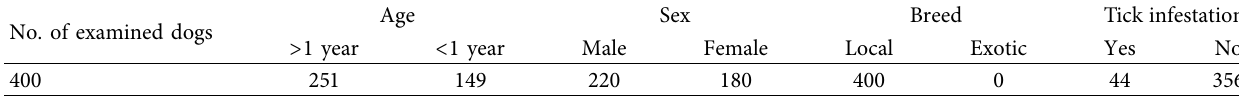
Table 2: Description of sampled dogs and tick infestation.